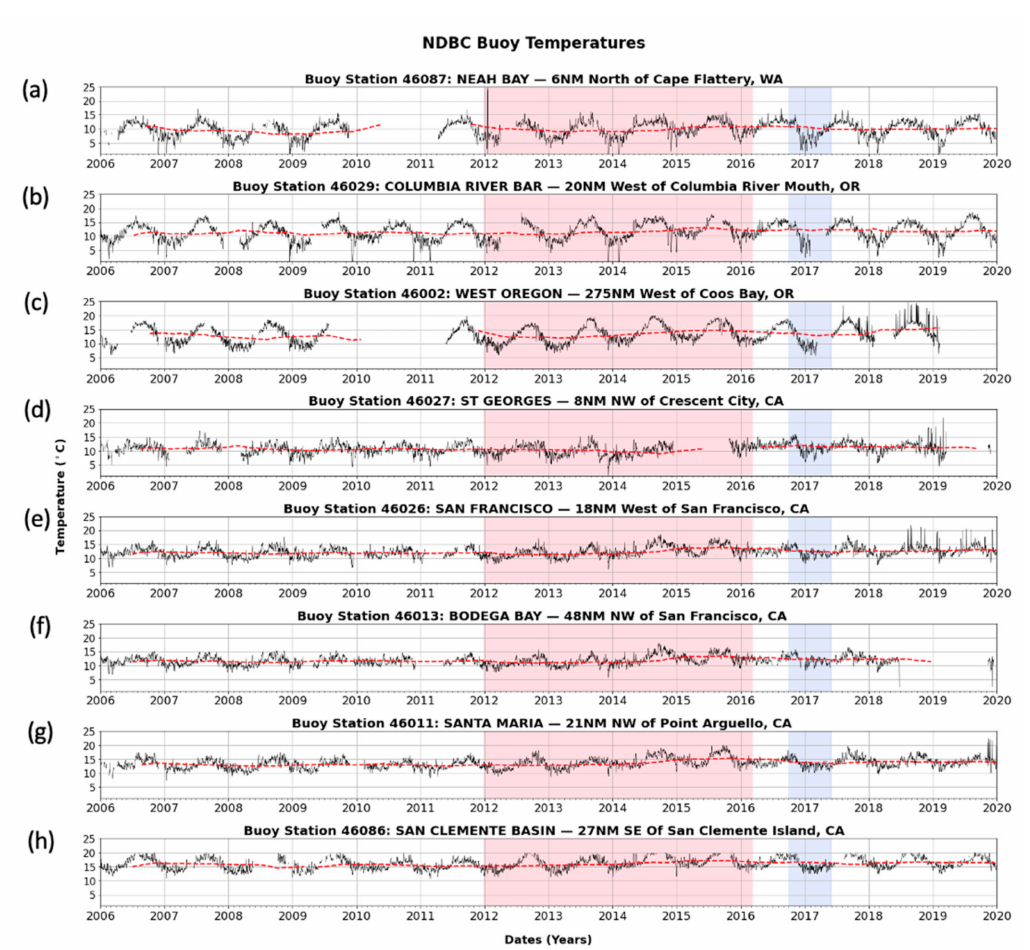
Figure 5. NDBC Buoy temperatures data for eight locations within the focus area: ( a ) West Oregon—275NM West of Coos Bay, OR, USA, ( b ) Santa Maria—21NM NW of Point Arguello, CA, USA, ( c ) Bodega Bay—48NM NW of San Francisco, CA, USA, ( d ) San Francisco—18NM West of San Francisco, ( e ) St. Georges—8NM NW of Crescent City, CA, USA, ( f ) Columbia River Bar—20NM west of Columbia River Mouth, ( g ) San Clemente Basin—27NM SE of San Clemente Island, CA, USA, and ( h ) Neah Bay—6 NM North of Cape Flattery, WA, USA). The area shaded in red highlights the third worst drought in California, while the extreme rain season is shaded in